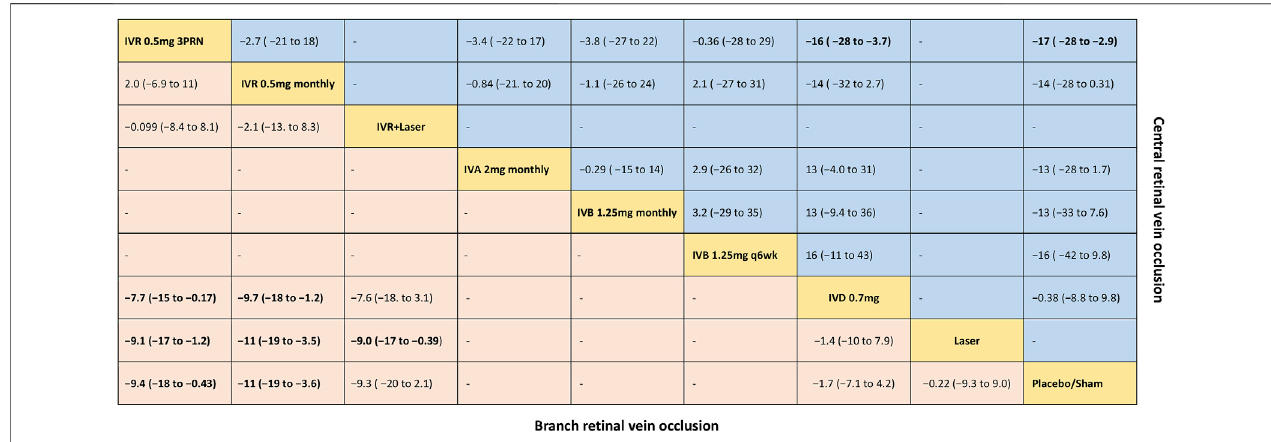
FIGURE 2 | Comparative effectiveness of pharmacotherapies in terms of the mean change in BCVA for macular edema secondary to retinal vein occlusion in networkmeta-analysis. Weighted mean difference (95% credible interval) for comparisons are in cells incommon between column-de fi ning and row-de fi ning treatment. Boldcellsaresigni fi cant.Forbranchretinalveinocclusion,weightedmeandifference < 0favorsrow-de fi ningtreatment.Forcentralretinal veinocclusion,weightedmean difference < 0 favors column-de fi ning